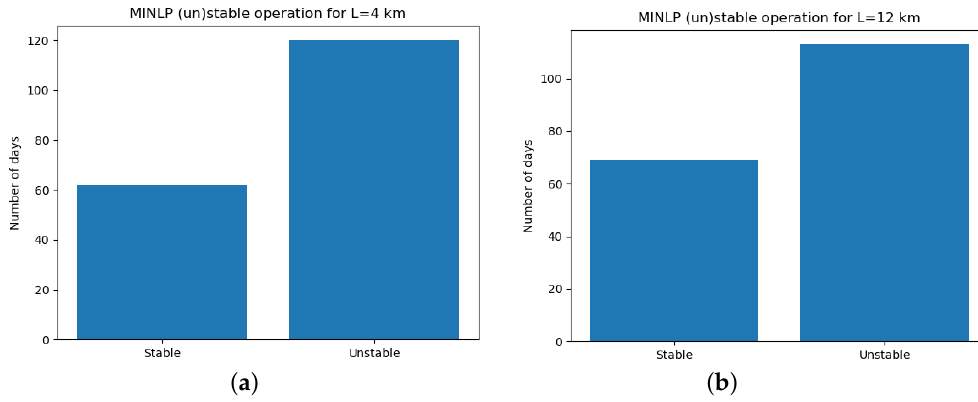
Figure 6. ( a ) Stable days for L “ 4 km. ( b ) Stable days for L “ 12